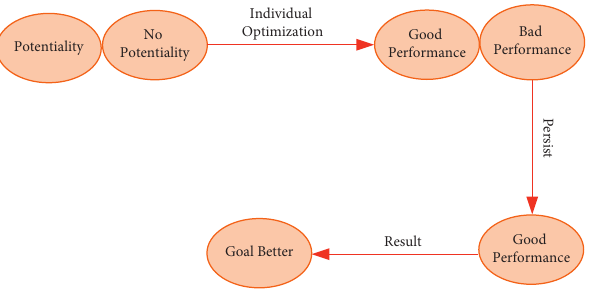
Figure 3: The diagram of the improved